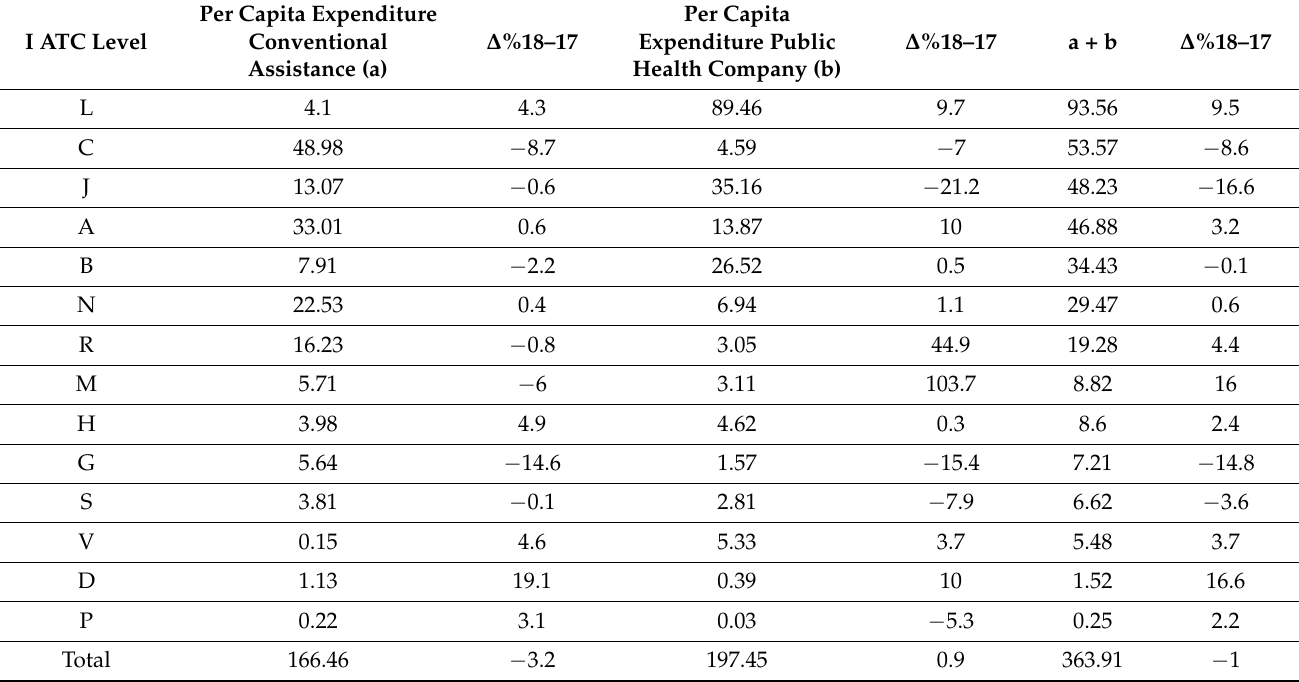
Table 1. National Health System (NHS) cost per capita for first ATC Levels: 2018–2017 comparison (data from the OSMED 2018 Report). A: gastrointestinal system and metabolism; B: blood and hematopoietic organs; C: cardiovascular system; D: dermatological; G: genito-urinary system and hormones; H: systemic hormonal preparations, excluding sex hormones; J: systemic-use antimicrobial; L: antineoplastic drugs and immunomodulatory; M: musculoskeletal system; N: